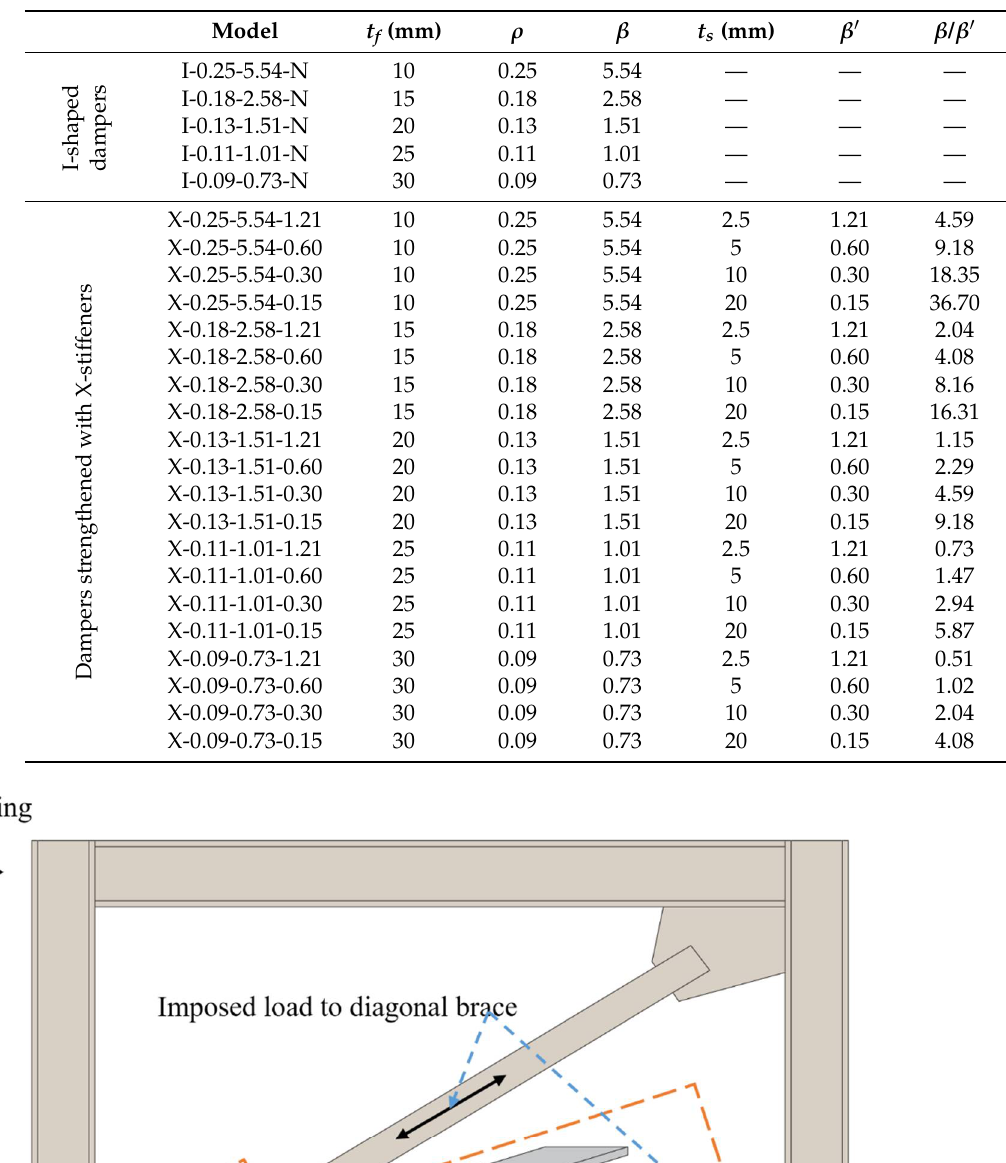
Table 1. Properties of numerical models.